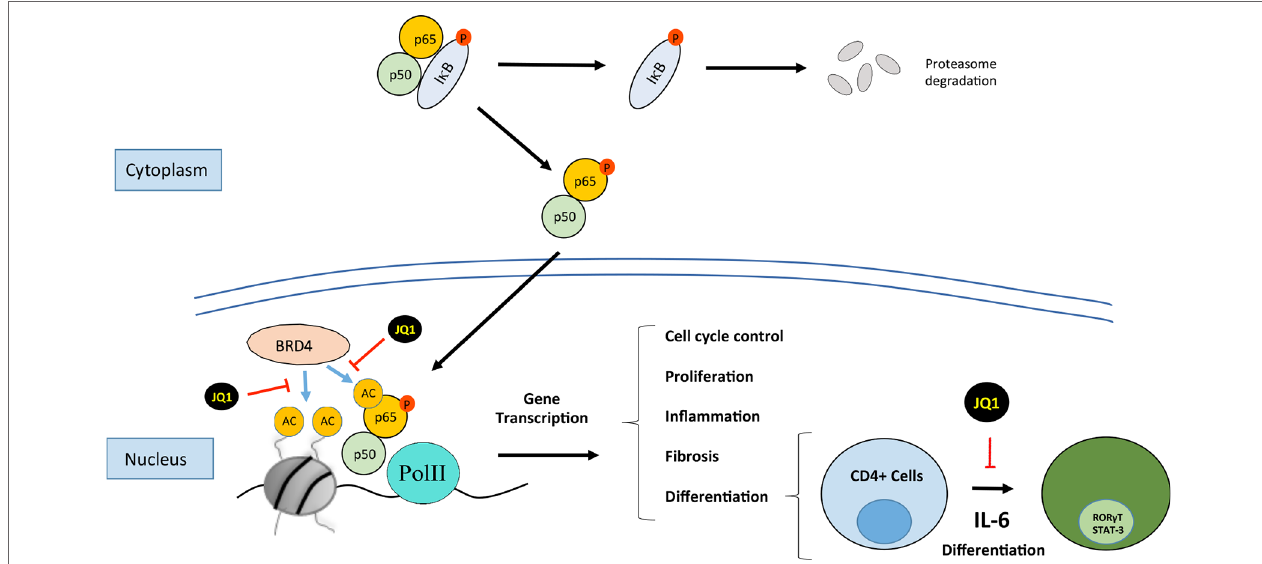
FIGURE 3 | Bromodomain and extraterminal (BET) proteins regulate cellular processes such as cell cycle, proliferation, differentiation, inflammation, and fibrosis. JQ1 binds to BRD4, this situation not allows the recruitment of p65 and finally it is ubiquitinilated and degraded by the proteasome. BRD4 interacts with NF-kB to induce the expression of genes associated with processes such as inflammation or TH17 immune